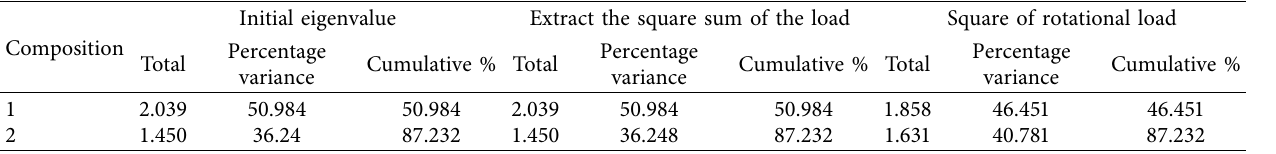
Table 3: Total variance explanation.